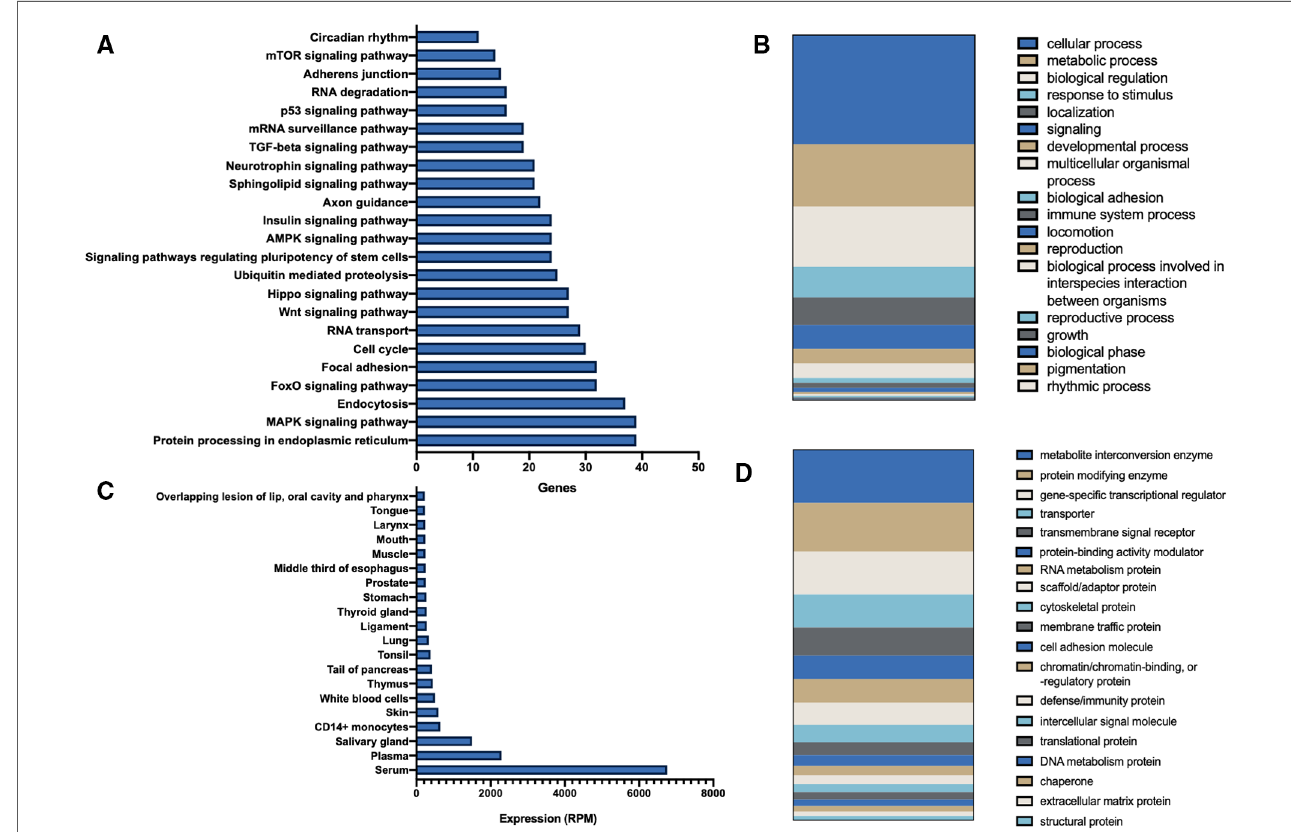
FIGURE 3 In silico analysis of mirR-106b-5p targets, functions and tissue expression. ( A ) KEGG analysis based on miRTarBase validated targets on miRpath v3. ( B ) miR-106b-5p miTED analysis for tissue levels. ( C ) Molecular process analysis of miR-106b-5p targets by mirWalk database and pantherdb tool. ( D ) Protein function analysis of miR-106b-5p targets by mirWalk database and pantherdb